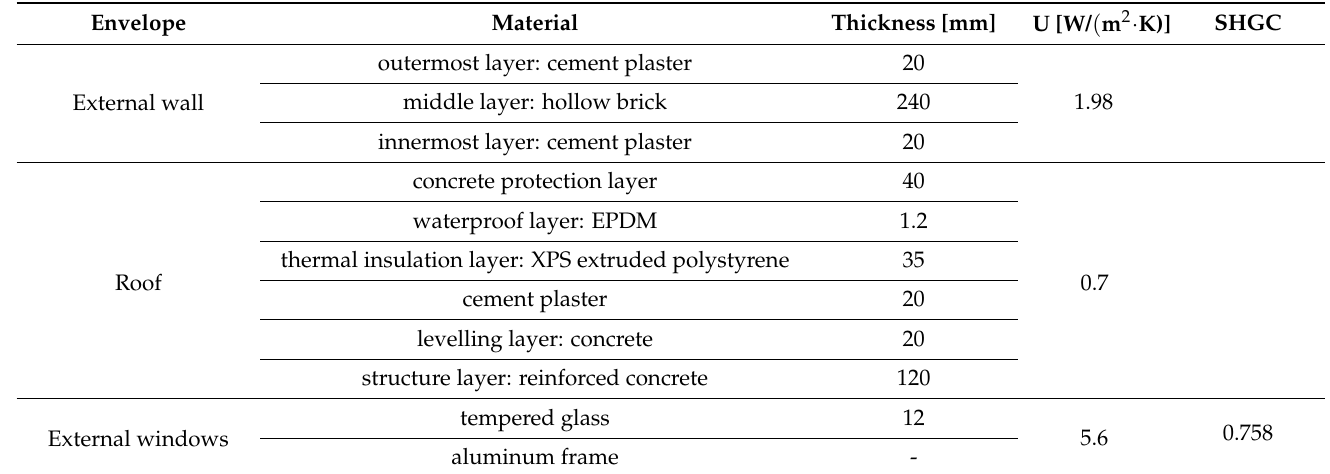
Table 2. Composition of main building envelope and thermal properties.